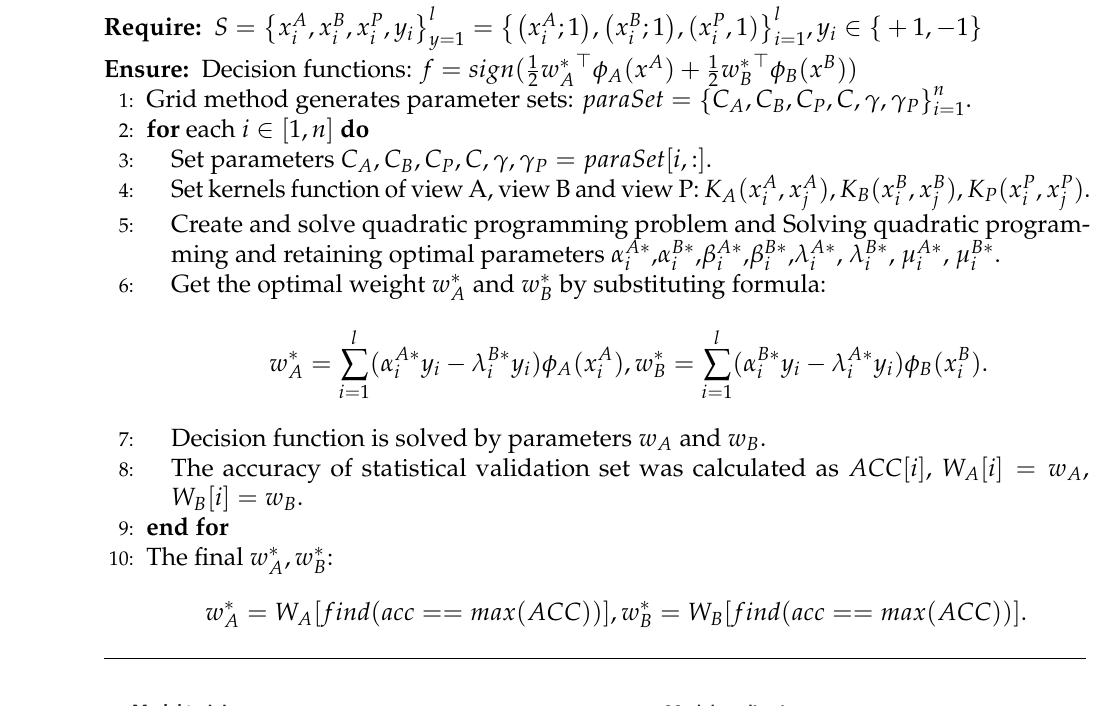
Algorithm 1 QP Algorithm for FIMV-SVM